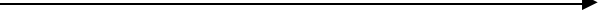
Fig. 1. a Map showing the bathymetry of Fram Strait and the positions of the stations and sections occupied by RV Polarstern and by RV Lance in summer 1997. The gray parts indicate stations used on more than one section. b Map of the Eurasian Basin showing the positions of the 1991 Oden-91 stations and 1995 ( ARKXI ) and 1996 ( ARKXII ) Polarstern stations discussed in the text